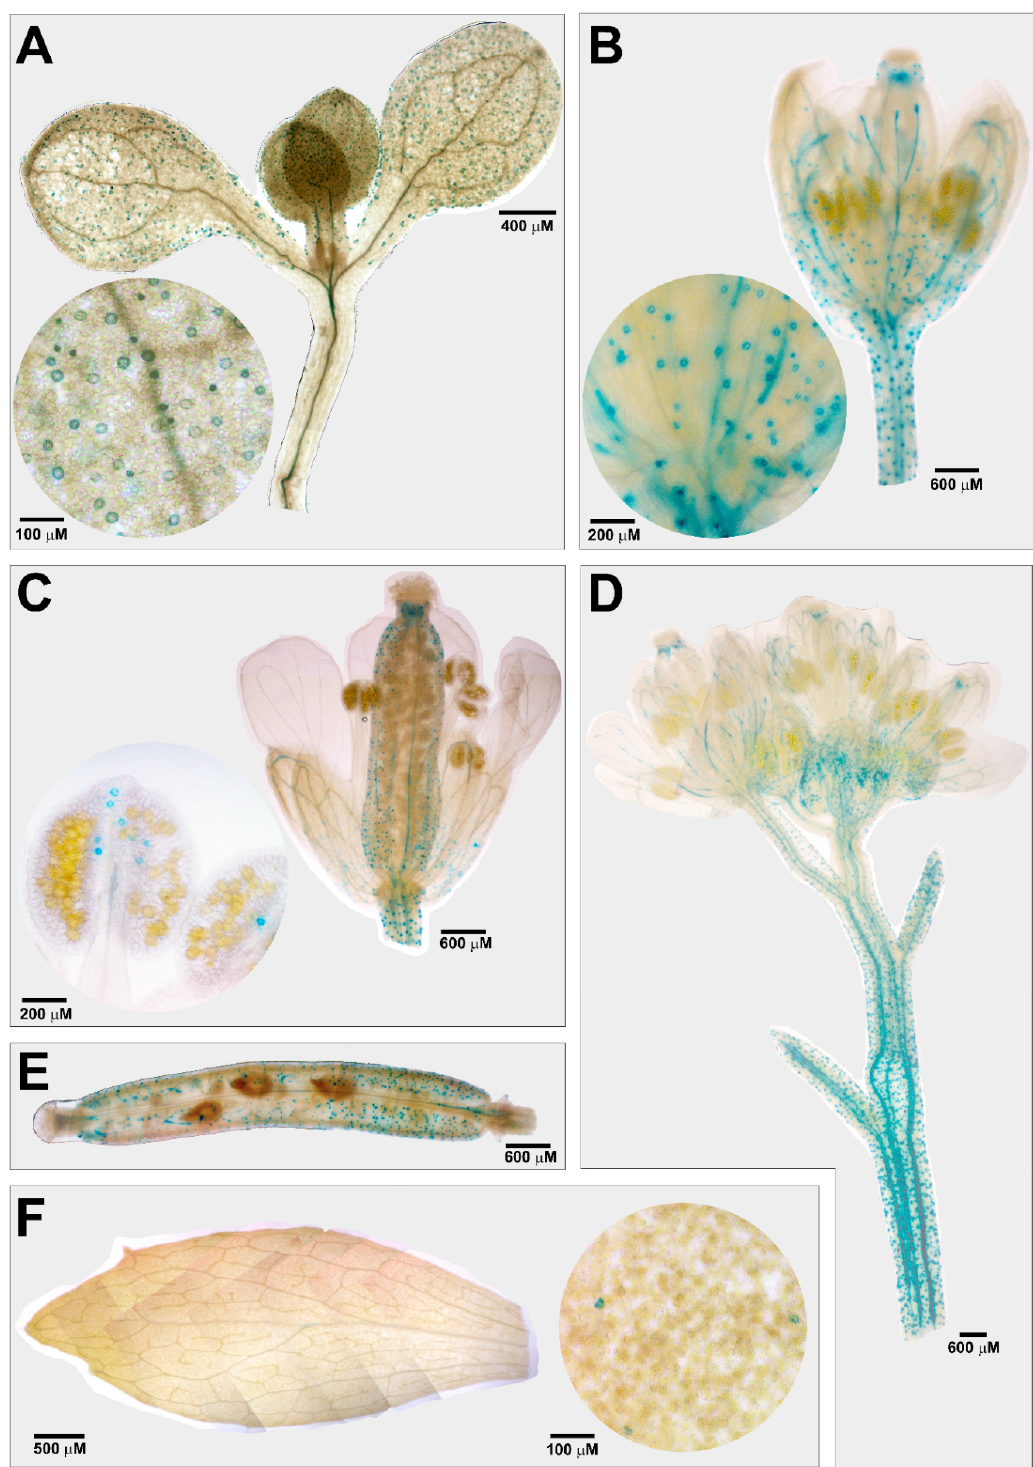
Figure 1. AtCuAO β tissue expression pattern in stomata of seven-day-old seedling ( A ) and in flowers ( B – D ), siliques ( E ) and leaves ( F ) of AtCuAO β ::GFP-GUS adult transgenic plants. The GUS staining reaction was allowed to proceed overnight. Highly reproducible results were obtained from three independent transgenic lines. Shown images were obtained aligning serial overlapping micrographs of the same samples by Photoshop Software (Adobe) and are representative of those obtained from 25 samples from five independent experiments. The circular images show the enlarged detail (stomata guard cells) of the corresponding representations in the inset.